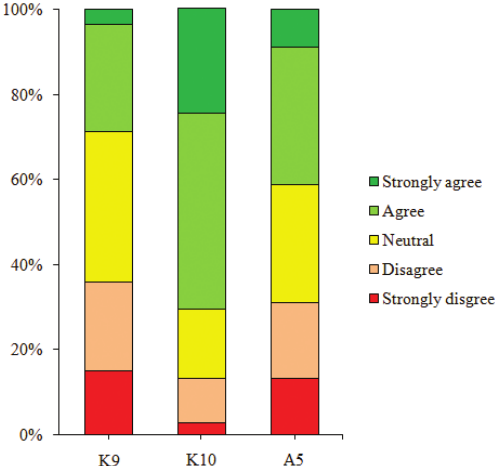
Figure A7. Cumulative responses to K9: “Rooppur is suitable